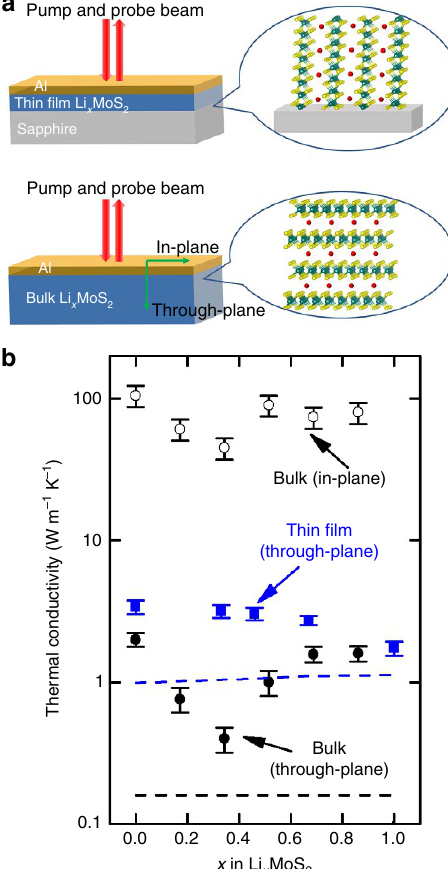
Figure 4 | Thermal conductivity measurement of Li x MoS 2 samples. ( a ) Schematics of bulk and thin-film Li x MoS 2 samples for TDTR measurements. ( b ) Thermal conductivity of Li x MoS 2 samples with different degrees of lithiation x . Blue squares: through-plane thermal conductivity of thin-film MoS 2 ; black squares: through-plane thermal conductivity of bulk MoS 2 ; black open squares: in-plane thermal conductivity of bulk MoS 2 . The minimum thermal conductivity for bulk and thin-film samples are plotted as black and blue dashed lines, respectively. The total uncertainties of the measured thermal conductivity are calculated by taking into account the systematic errors that propagate from uncertainties in the film thickness, laser spot size, and thermal properties of the transducer film and plotted in Fig. 4b as dashed lines. Both measured through-plane